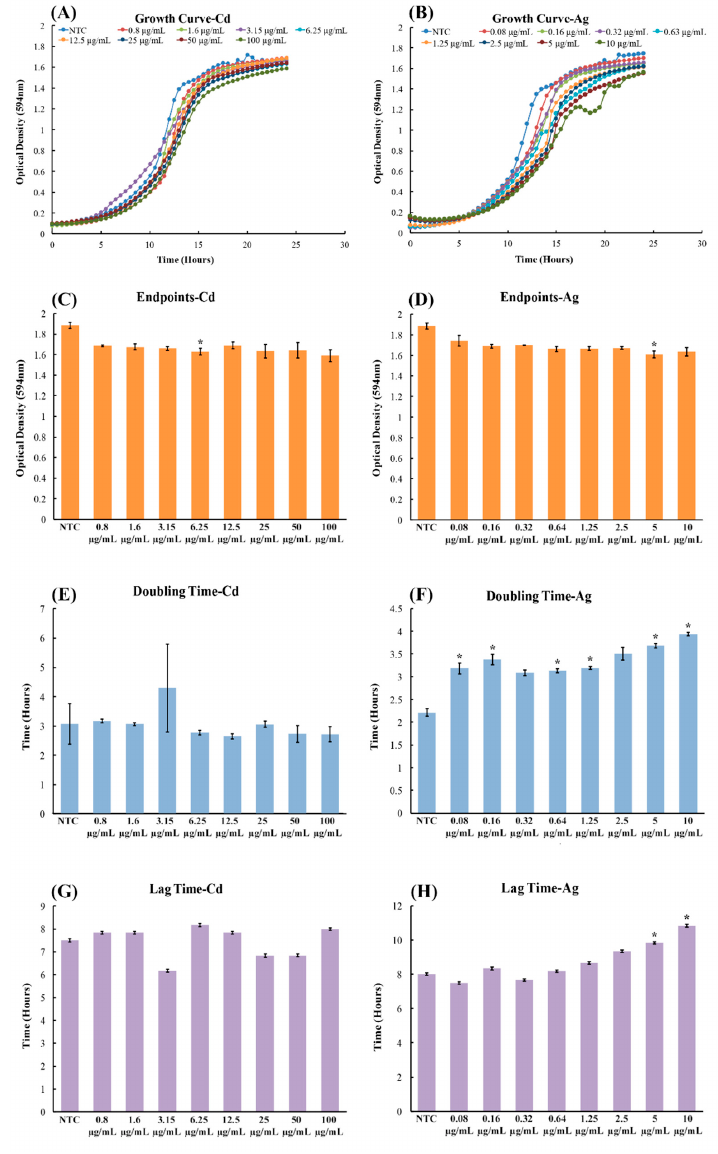
Figure 1. Growth assay to determine growth rates of CdSe / ZnS and AgNP-treated yeast cells. ( A , B ) Quantification of cell optical densities over a 24 h period, where the cells were treated with CdSe /